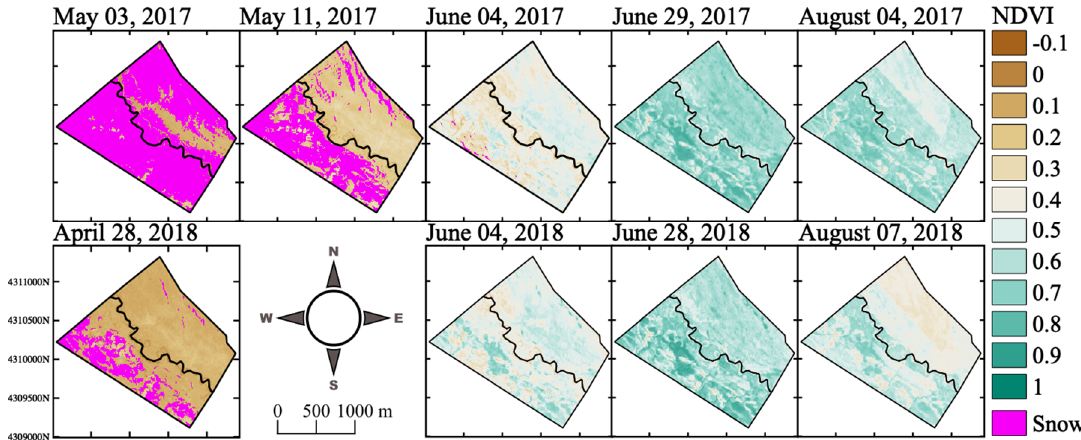
Figure 6. A portion of the time series of NDVI and snow classification from satellite imagery. Key dates in both years show snow cover, plant growth, peak or near-peak NDVI and senescence. Black lines outline the boundary between the north ( left ) and south ( right ) facing aspects. The full time series of images is included in the supplementary materials (Figure S2).